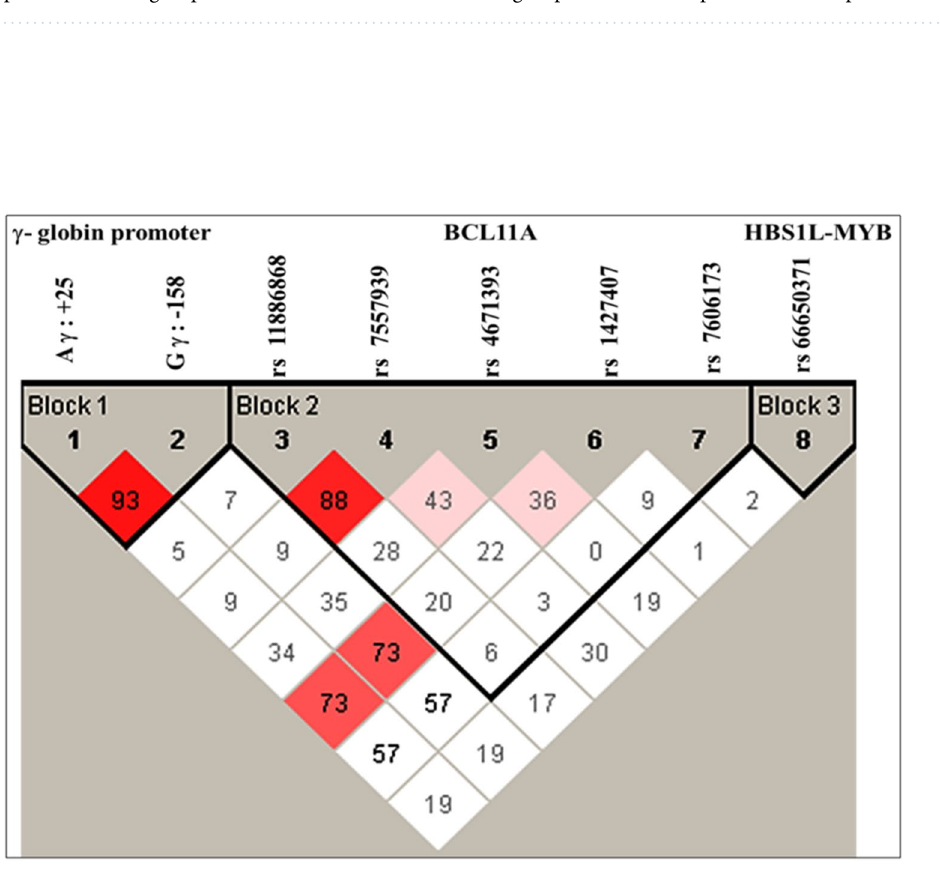
Table 3. Genotypic and allelic frequency of the polymorphisms in patient and control group. n Number of patients in each group, N Total number of alleles in each group. *Thalassemia patients. **SCA patients.